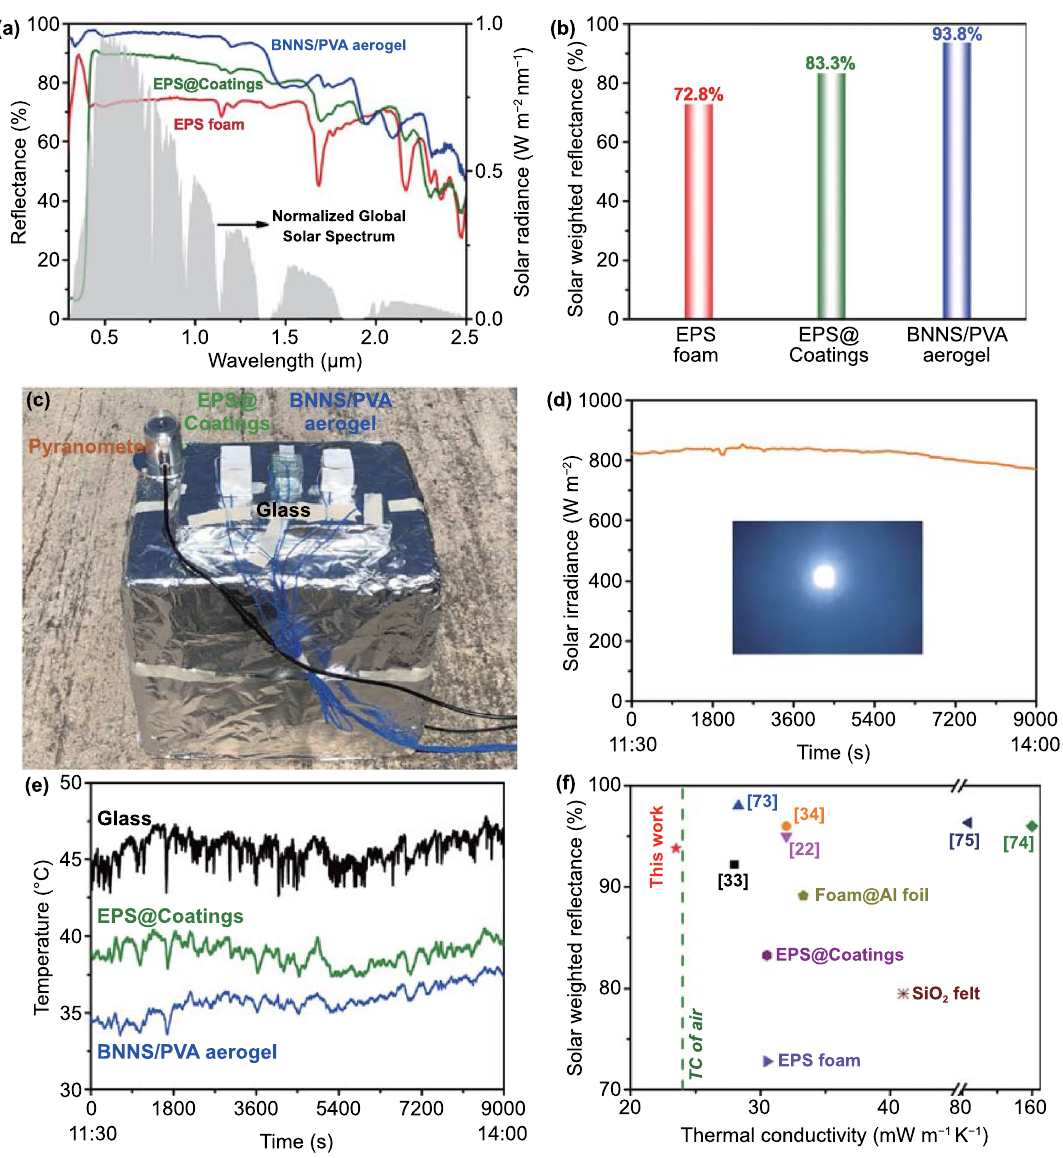
Fig. 5 Superinsulating solar‑reflection BNNS/PVA composite aerogel for energy‑saving buildings. a UV–vis‑NIR spectra of 9‑mm‑thick BNNS/PVA composite aerogel, EPS foam and EPS@Coatings presented against normalized ASTM G173 global solar spectrum. b Solar weighted reflectance of the BNNS/PVA composite aerogel, EPS foam and EPS@Coatings. c Setup, d real‑time solar irradiance with the real‑ time weather condition in inset, and e real‑time temperature curves inside the boxes assembled using the BNNS/PVA composite aerogel, EPS@ Coatings and glass when exposed to sunlight (Mostly sunny, July 09, 2021 in Hong Kong). f Comparison of solar reflectance performance with respect to TC of the BNNS/PVA composite aerogel with thermally insulating materials reported in the literature, including PE aerogels [33, 34, 73], nanowood [22], cooling wood [74], and PVA porous film [75], and commercial products including neat EPS foam, EPS@Coatings, SiO 2 felt, and foam@Al